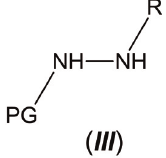
Fig. 3. Structure of α -aza-amino acid